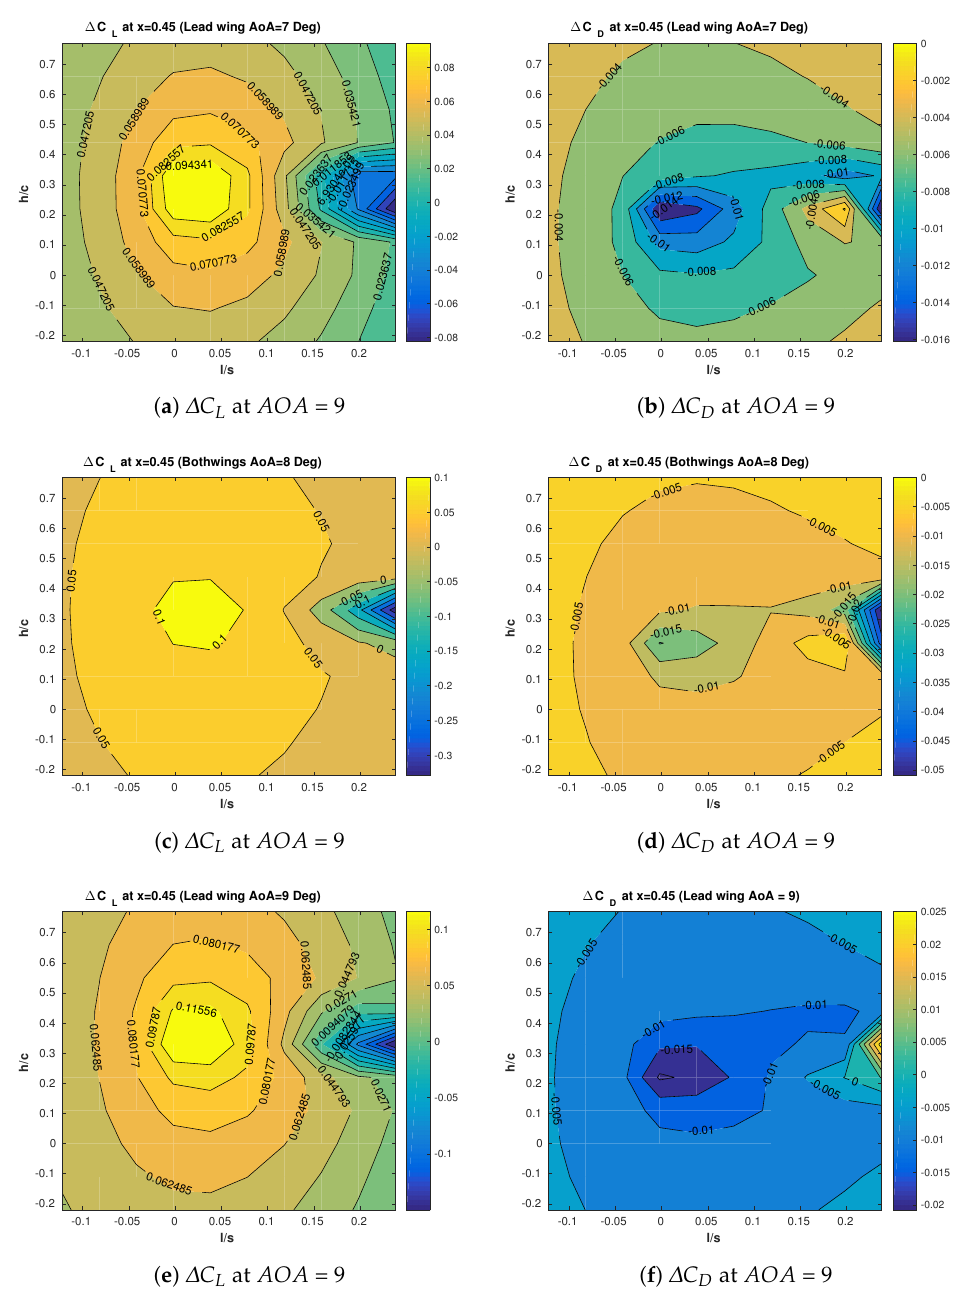
Figure 12. Contours of lift ( ∆ C L ) and drag coefficient ( ∆ C D ) percentage change for three lead wing incidence angles at streamwise distance of x =